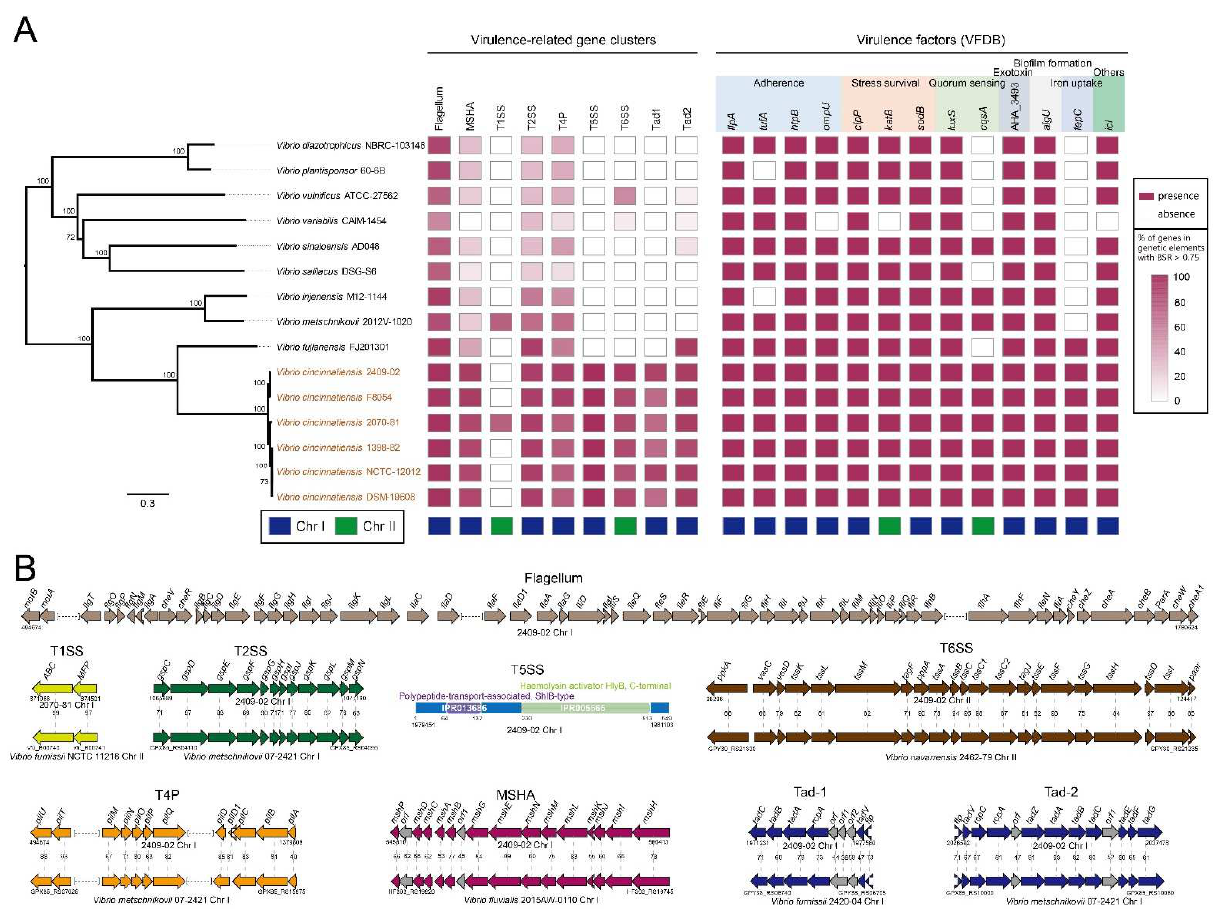
Figure 8. The genotypic profiles of virulence-related elements across six V. cincinnatiensis genomes. ( A ) Distribution of virulence-related elements. Color coding for virulence gene is based on the BLASTp parameters (E-value cutoff value of <1 × 10 − 6 , identity value of >60%, and coverage value of >60%) calculated when the genomic data were screened against the reference sequences of VFDB database. Color coding for the gene clusters is based on the percentage of genes on a cluster that are present in a genome (defined as the BLASTp parameters of query gene with E-value cutoff value of <1 × 10 − 6 , identity value of >60%, and coverage value of >60%); ( B ) the genetic organization of virulence-related elements. Homologous genes are shown in the same color and linked by dotted lines. The percentages of protein identities of homologous genes are shown.